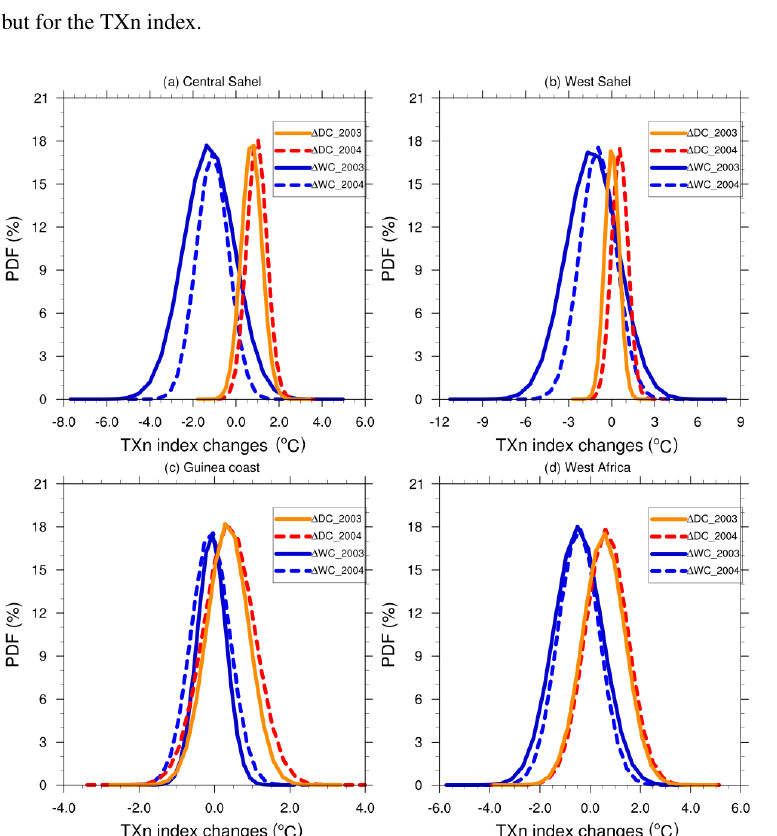
Figure 17. Same as Fig. 15 but for the TXn